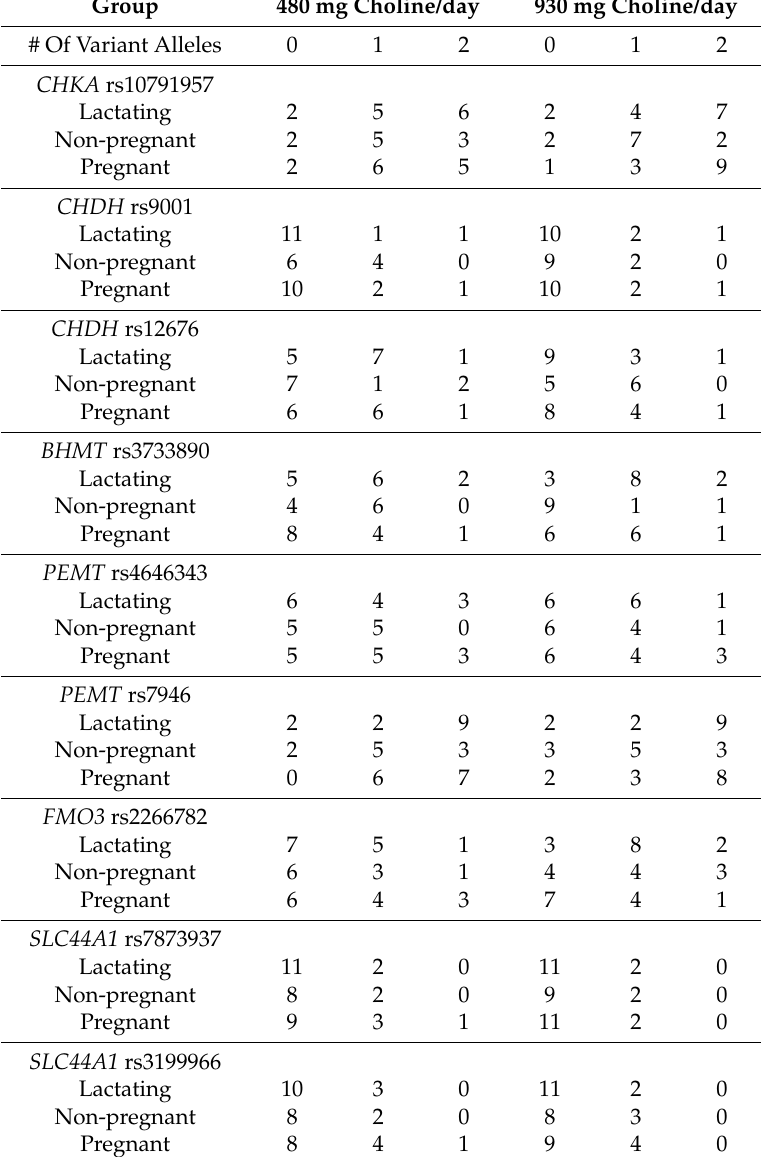
Table 2. Genotype distribution (# of participants) among reproductive states and choline intake groups. Group 480 mg